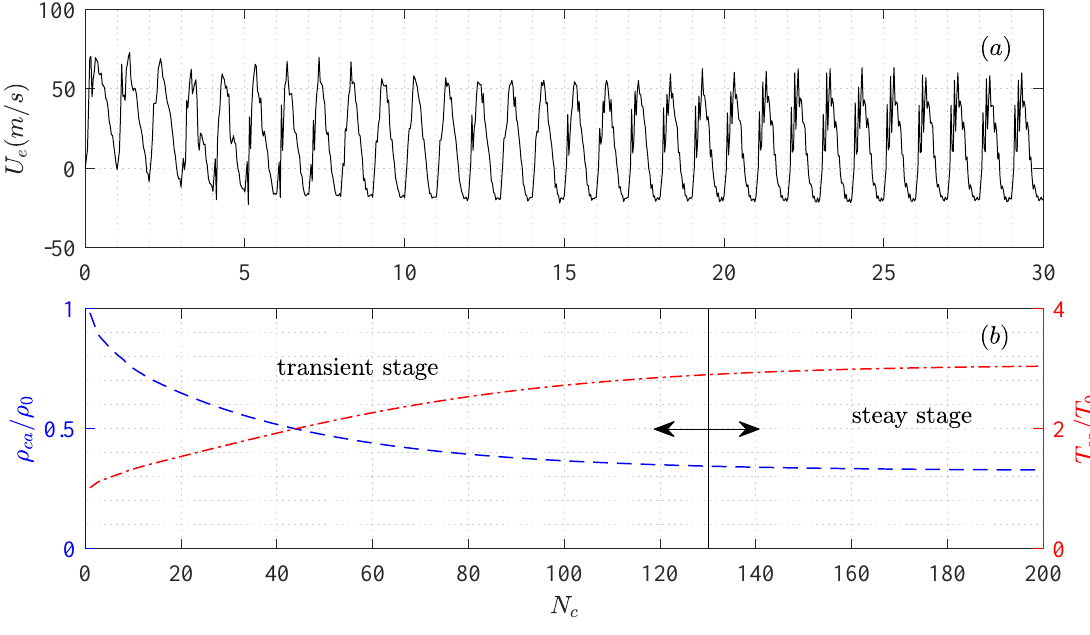
Figure 6. ( a ) Time-resolved jet exit velocity in the first 30 cycles after discharge ignition ( f ∗ = 1.05); ( b ) Evolution of the mean cavity temperature (dash line) and mean cavity density (dash-dot line) in the initial 200 cycles after start-up. N c is the cycle number ( t / T d